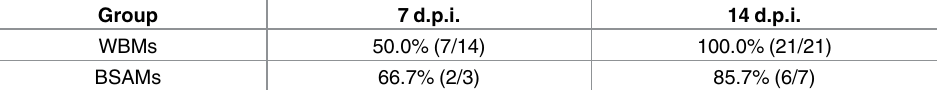
Table 3. Dissemination rate of ZIKV in Ae . aegypti receiving infectious blood meals and protein meals at 7 and 14 d.p.i.